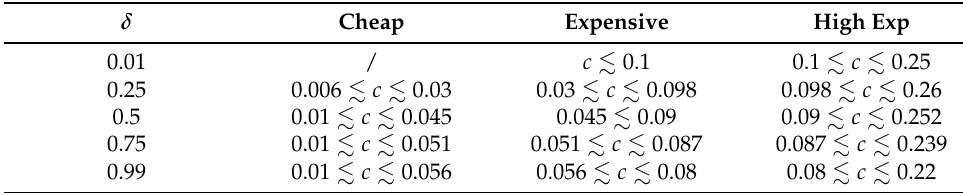
Table 2. Existence